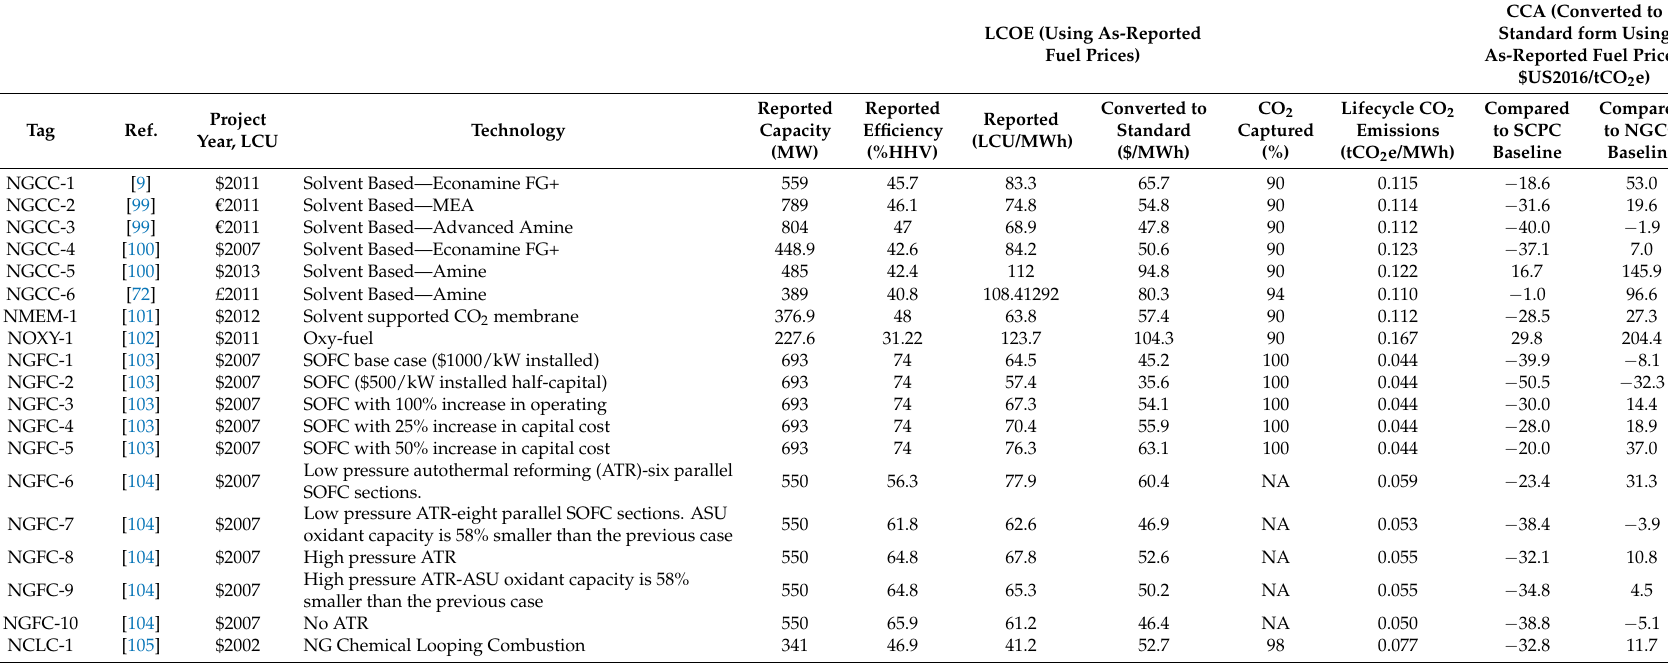
Table 3. Gas-fired power plants surveyed in the meta-study, with key metrics shown. For other metrics and intermediate calculations, please see the Microsoft Excel file included with the supplementary material. Notes: tCO 2 e is in metric tonnes. LCU = local currency unit (given in third column). Converted to Standard means that the plant has been converted to the standard size, project year, and locale according to the methods described in Section 2.